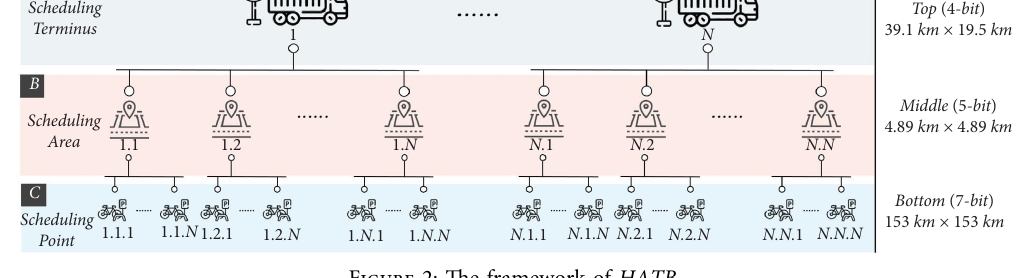
Figure 2: Te framework of HATB .